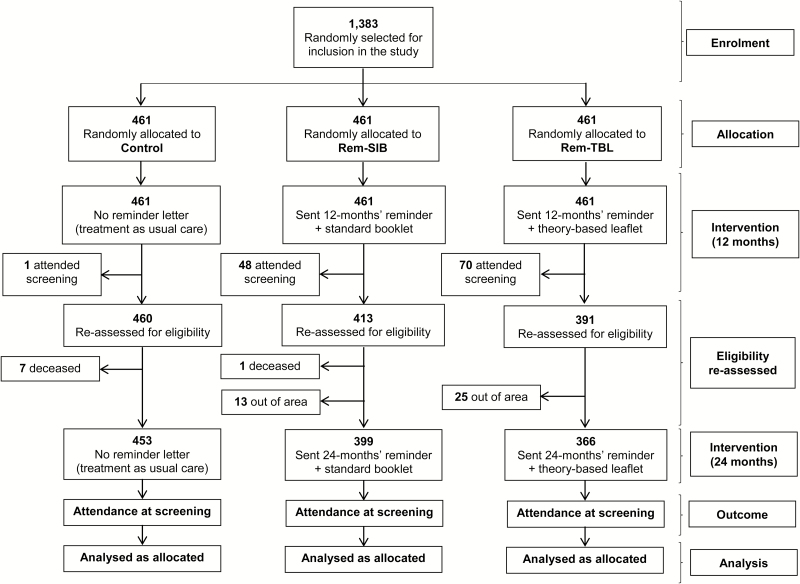
CONSORT diagram.